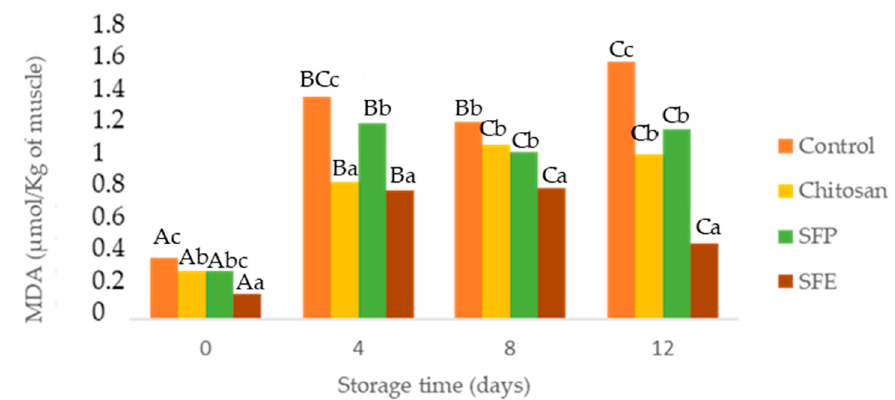
Figure 3. Determination of malondialdehyde (MDA) in Atlantic horse mackerel coated with different film formulations (control without coating film, chitosan, sea fennel plant (SFP) incorporated in a chitosan-based film and sea fennel extract (SFE) incorporated in a chitosan-based film) and stored at 4 °C for 12 days. Different uppercase letters indicate significant differences ( p < 0.05) over storage time in each treatment. Different lowercase letters indicate significant differences ( p < 0.05) due to the treatment.